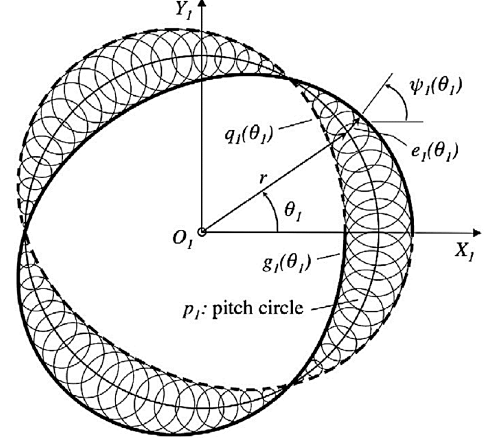
Figure 11. Deviation-function method (Warren and Yang [82]). Hsieh and Cheng used CFD methods to analyze the effect of variations in the geometric design curve (K factor) on the flow characteristics of rotary engines. They found that a lower K factor produces more leakage, high internal pressure variations, and unstable inlet pressure. In contrast, a high K factor reduces the leakage followed by lower internal pressure variation, and stable inlet pressure [85]. Figure 12 shows the design for various K factors of REs. In Figure 12a–c, the sun gear constructed from the theoretical rolling circle is shown in blue and the fixed circle is shown in red. Based on the movement trajectory principle of points the housing curve constructed should confirm with the rotor profile such that the fixed circle rotates along rolling circle. Figure 12d presents design results of three different K factors analyzed. The small K factor (K = 6) is shown in pink color, the medium K factor (K = 7.5) is shown in blue color and the large K factor (K = 10) is shown in red color.